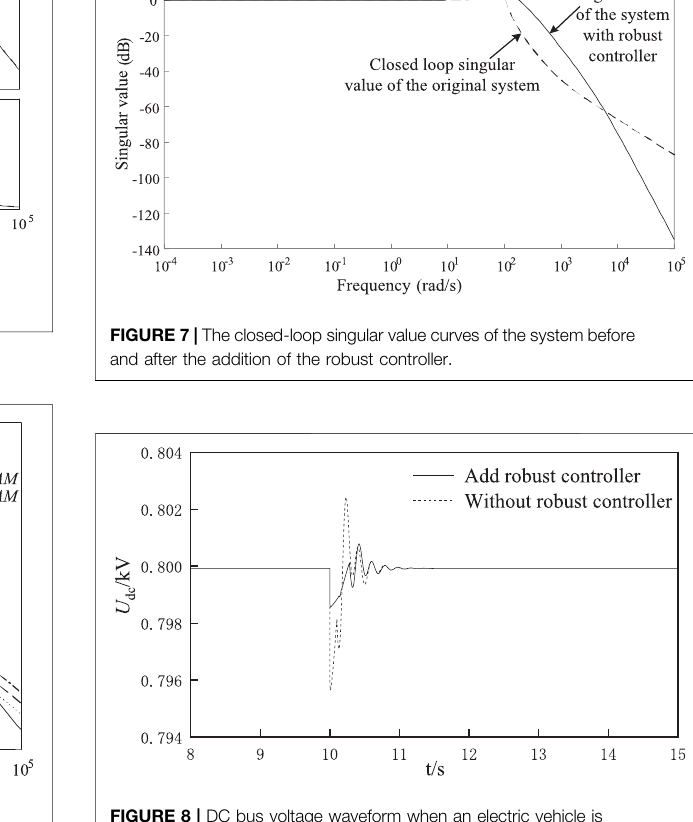
FIGURE 6 | Open-loop singular value curve after adding robust controller.